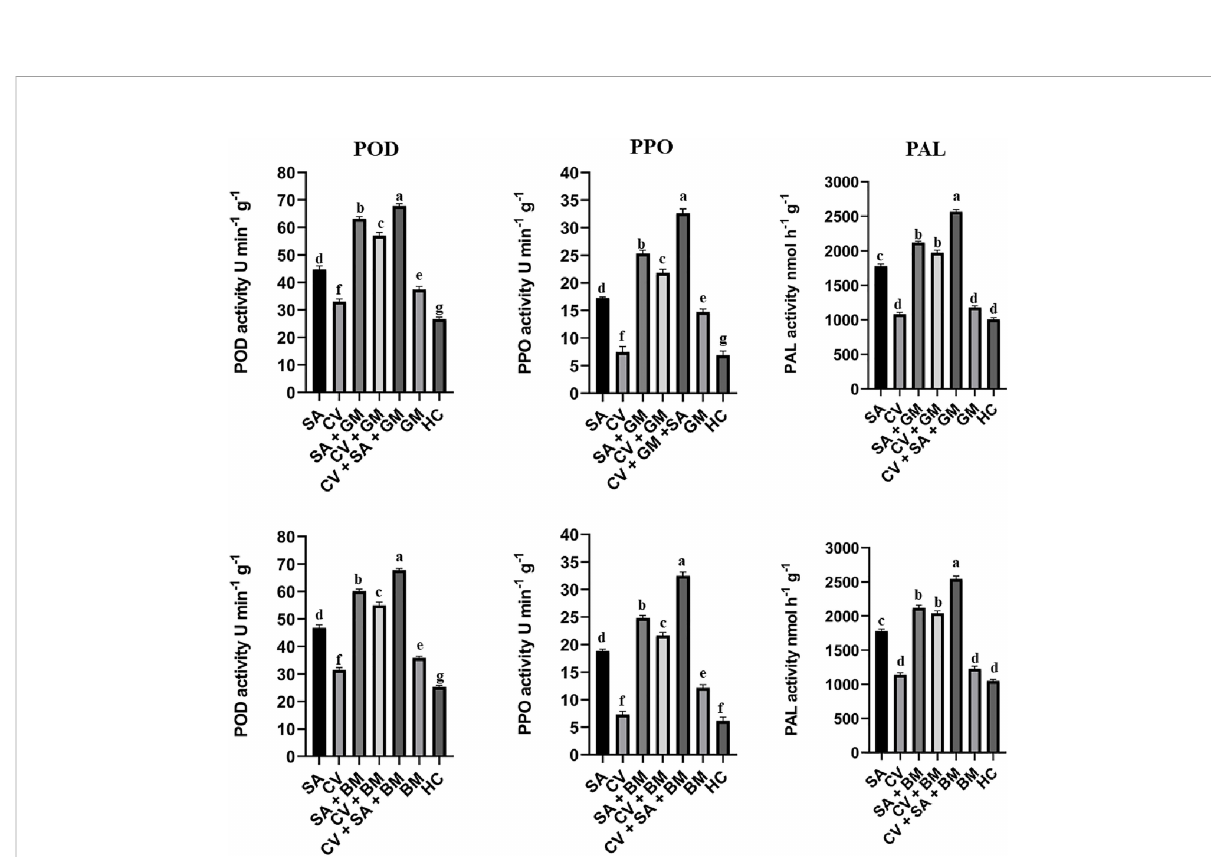
FIGURE 3 Activity of PPO, POD, and PAL in sweet oranges treated with combined and stand-alone applications of SA and C. verum. Error bars represent the standard error (± SE) of treatment means. Means with different alphabets over the columns indicate that the treatments are signi fi cantly different from each other. PPO, Polyphenol oxidase; POD, Peroxidase; PAL, Phenyl alanine ammonia-lyase; SA, Salicylic acid; CV, Cinnamomum verum; GM, Green mold, BM, Blue mold, HC, Healthy